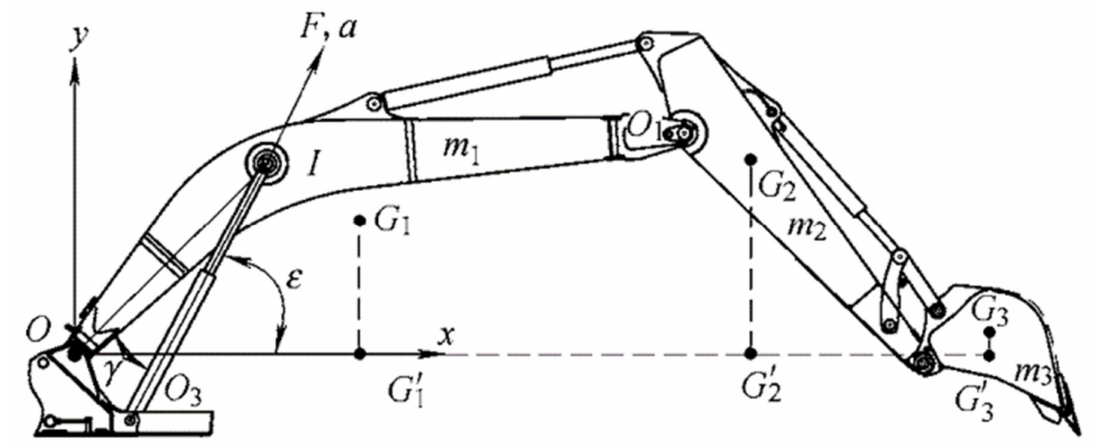
Figure 11. Force diagram of the hydraulic excavator